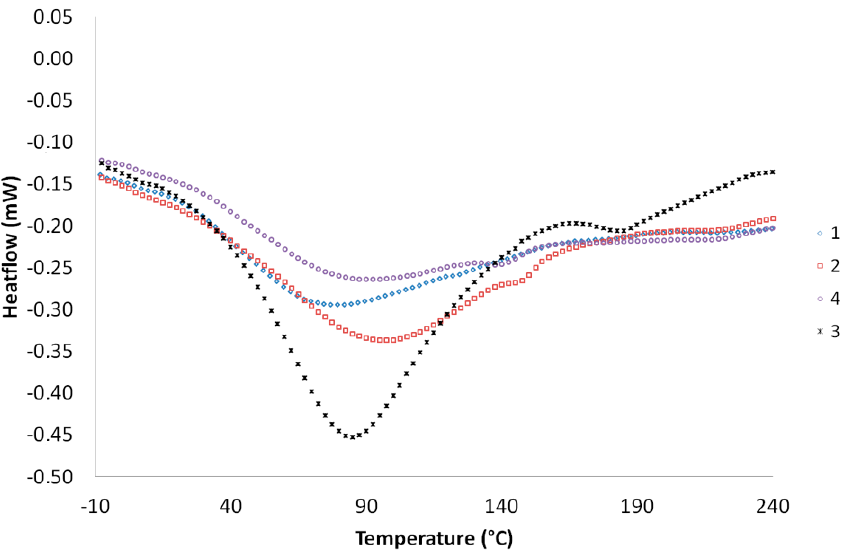
Figure 6. DSC thermograms of samples 1–4 showing their respective denaturation temperatures.